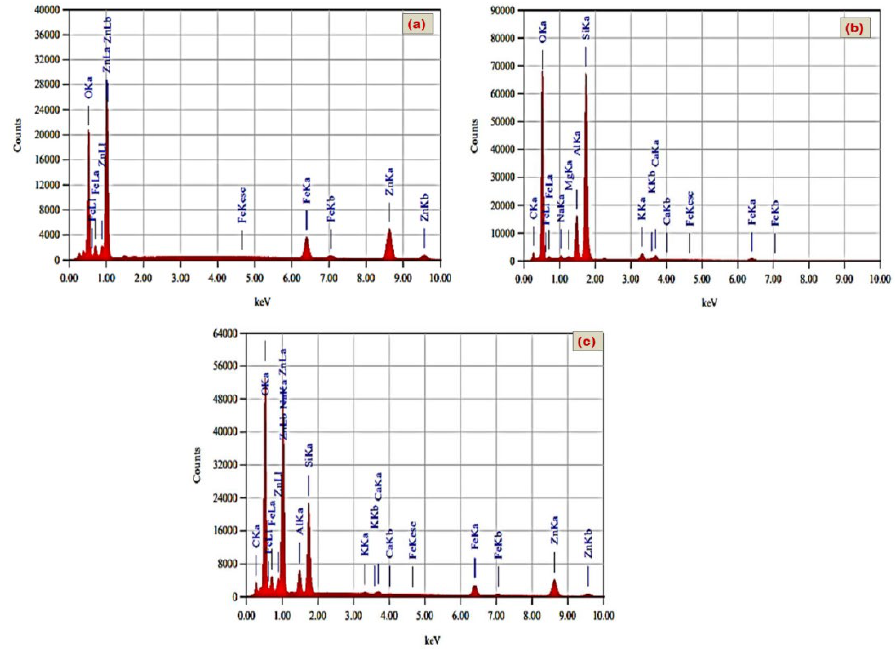
Figure 1. EDX of the prepared Zn-Fe LDH ( a ); zeolite ( b ) and zeolite/Zn-Fe LDH nanocomposite( c ).